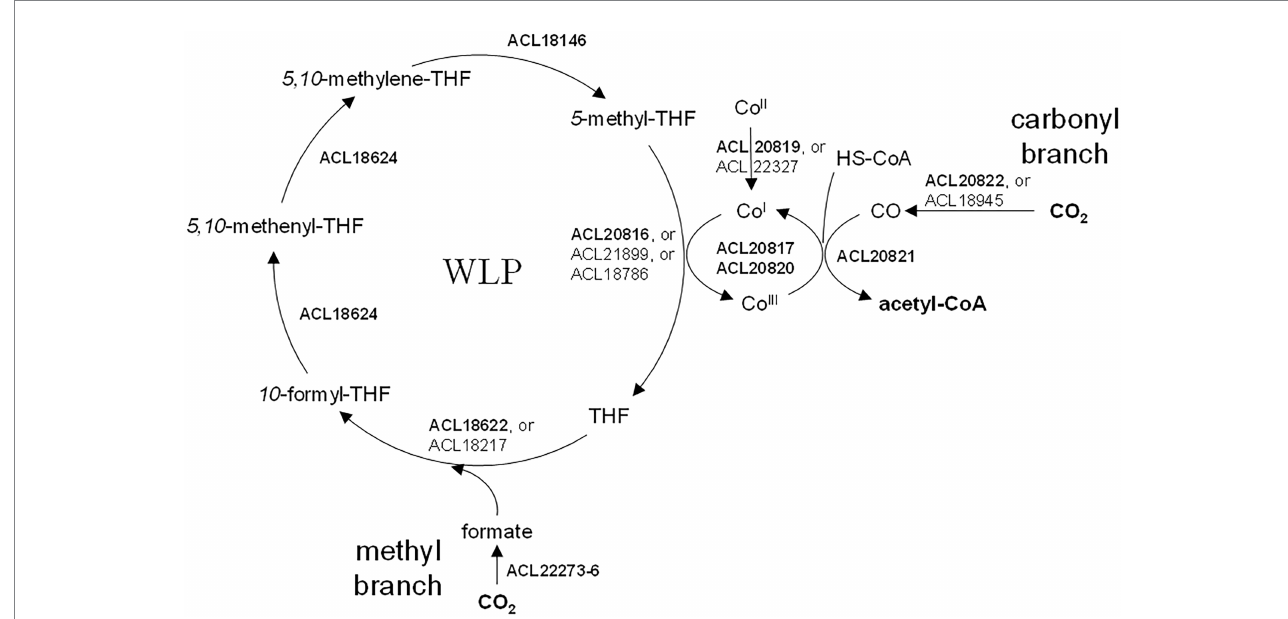
FIGURE 4 The Wood-Ljungdahl pathway in Desulfitobacterium hafniense strain DCB-2. The proteins involved in WLP were identified by sequence homology with the well-characterized enzymes from Carboxydothermus hydrogenoformans (Can et al., 2014; Jeoung et al., 2014). All indicated proteins were detected as significantly up-regulated in presence of H 2 in the medium (as compared to lactate). When several homologs are indicated, the most likely enzyme involved in WLP is indicated in bold. See Table 2 for details on the level of